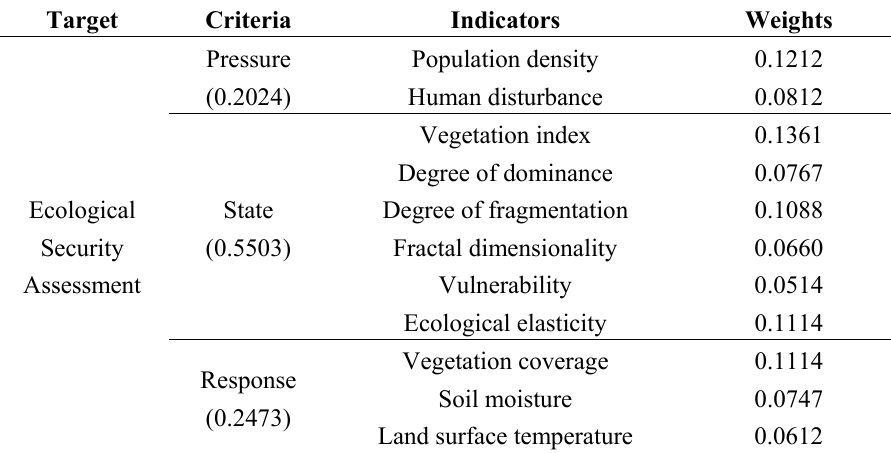
Table 3. Ecological security evaluation indicators and their weights.